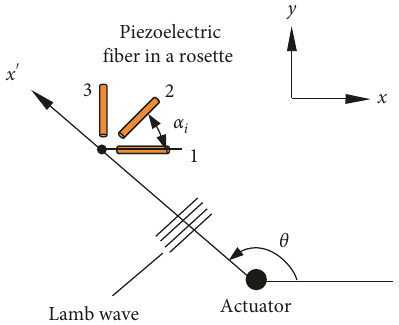
Figure 3: Estimation of the Lamb wave propagation